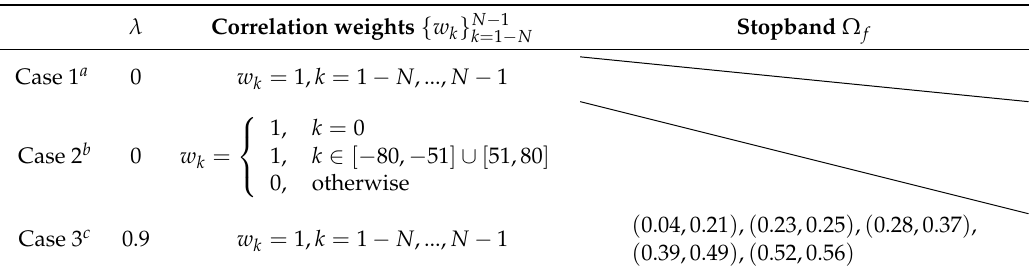
Table 2. Simulation parameters of different design